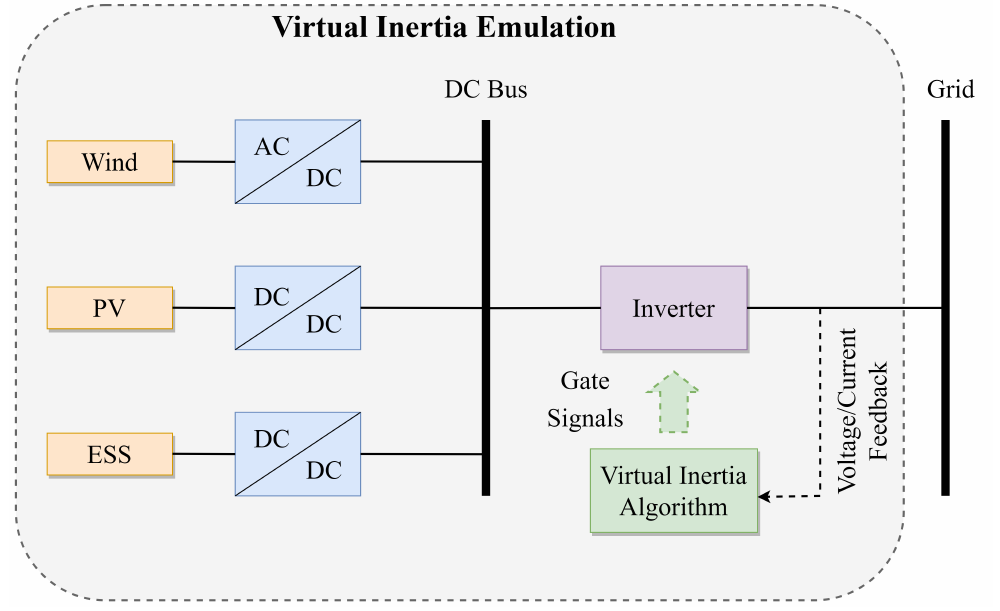
Figure 6. Concept of Virtual Inertia